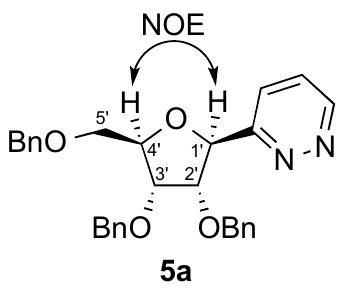
Figure 1. NOESY correlation in 5a . The novel conditions were applied to furan 2b and, in good total yield, led to the new 4-(ribofuranosyl)pyridazine 5b (Scheme 4). The β -configuration was also confirmed for 5b by the 2D-NOESY